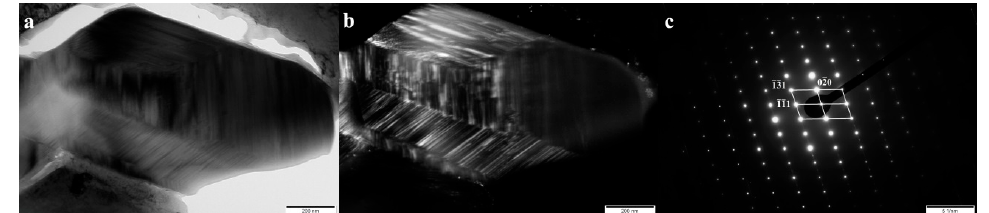
Figure 5. ( a ) Bright field image of the primary M 7 C 3 carbide in layer I. ( b ) Dark field image obtained from reflection (0–20) shown in ( c ). ( c ) Selected area diffraction pattern (SAED) of the primary M 7 C 3